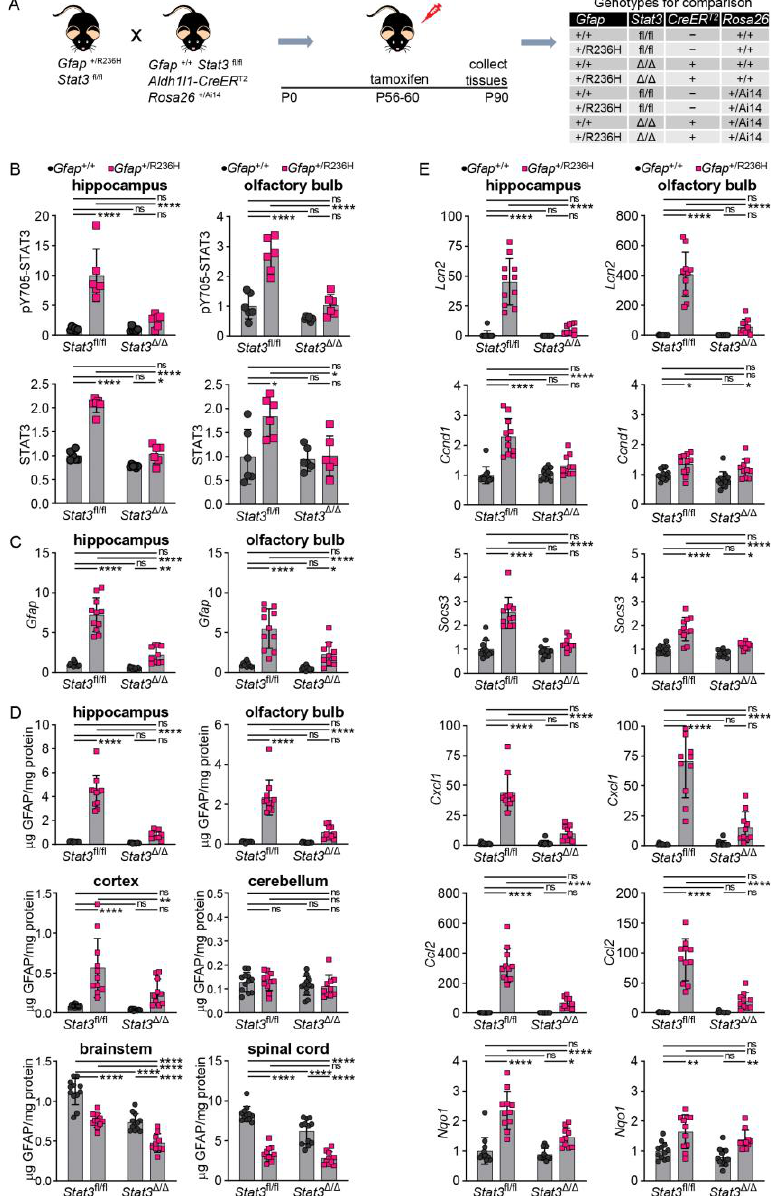
Figure 7. STAT3, GFAP, and other stress and immune related markers in AxD model mice after induced genetic knockout of Stat3 in astrocytes. ( A ) Genetic cross to generate Gfap +/R236H mice and Gfap +/+ littermate controls with both Stat3 alleles floxed (fl/fl) and a tamoxifen-inducible Aldh1l1 - promoter driven CreER T2 transgene. All mice were treated with tamoxifen at 2 months of age for 5 days, and tissues collected at 3 months of age. Timeline in right panel shows targeted postnatal (P) days. Stat3 alleles in animals expressing the Aldh1l1 -CreER T2 transgene are indicated as ∆ (Stat3 ∆ / ∆ ). ( B , C ) Quantitation of pY705-STAT3 and total STAT3 protein by immunoblotting ( B ), and Gfap transcript by qPCR ( C ) in hippocampus and olfactory bulb. ( D ) GFAP protein quantification in multiple brain regions and cervical spinal cord. ( E ) Quantification of transcripts reflecting reactive gliosis ( Lcn2 ), STAT3 activation ( Ccnd1 , Socs3 ), neuroinflammation ( Cxcl1 , Ccl2 ), and oxidative stress ( Nqo1 ) in hippocampus and olfactory bulb. Values in ( B ) are normalized to total protein and in ( C , E ) to Rn18s , and all represent fold change relative to the average for Gfap +/+ ; Stat3 fl/fl ; Cre (-) mice. C57BL/6J males and females, two-way ANOVA with Sidak’s post-tests, * p < 0.05, ** p < 0.01, **** p < 0.0001, ns = not